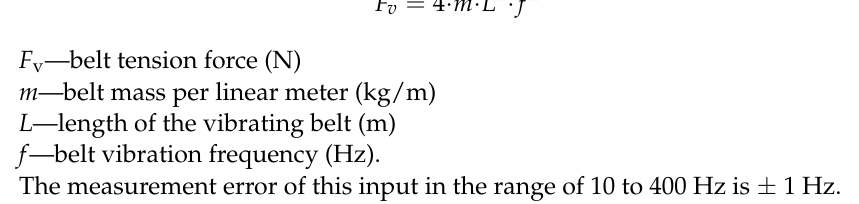
Figure 5. Test stand for kinematic and dynamic characteristics of the transmission, where: 1—stand base, 2—hydraulic motor, 3—flexible coupling, 4—active shaft of the belt transmission, 5—torque meter, 6—rotary-code sensor, 7—magnetorheological brake, 8—laboratory power supply, 9—measuring amplifier, 10—inductive sensor.